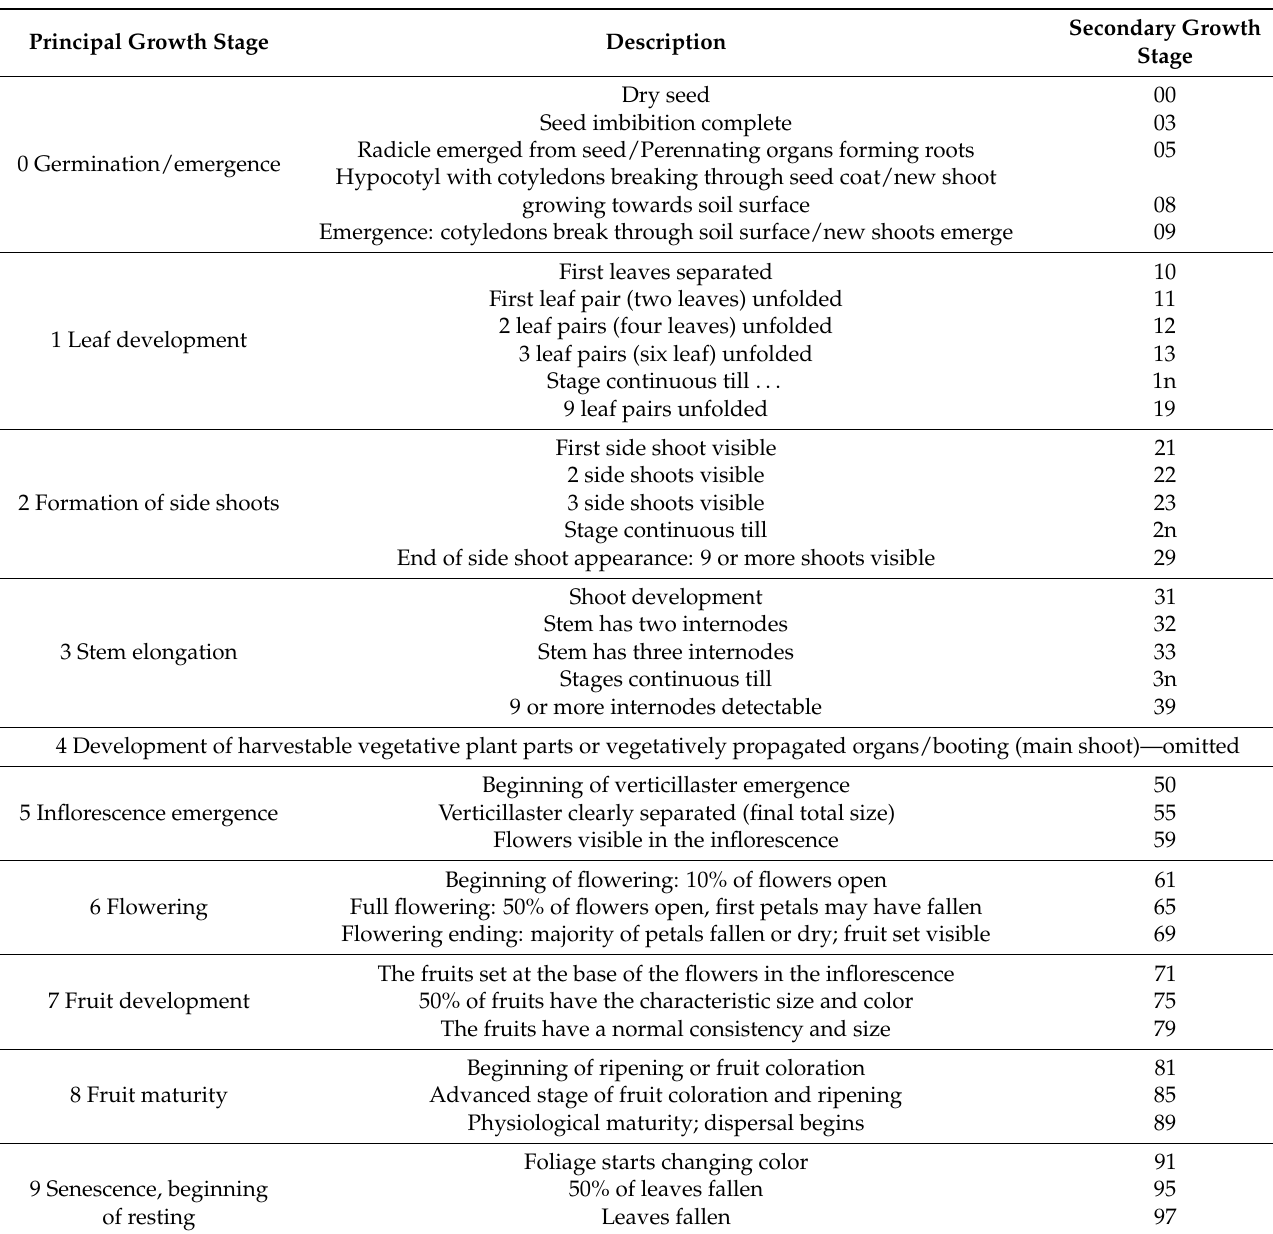
Table 3. Description of the phenological growth stages of Agastache , according to the BBCH